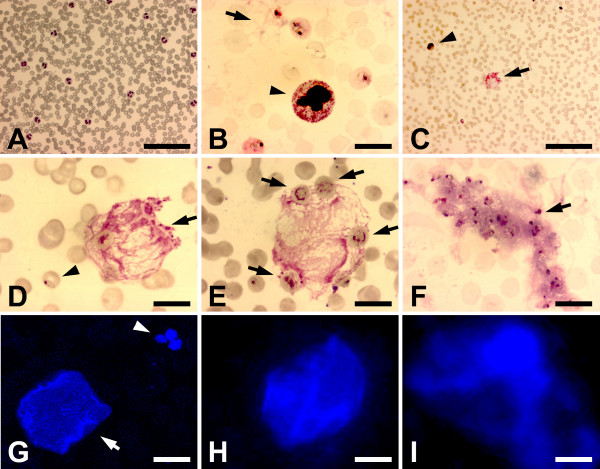
Giemsa- and DAPI-stained peripheral fingerprick blood smears from children 5 years old and younger presenting with uncomplicated malaria. (A) low magnification field of a control smear from a child presenting with fever but no detectable P. falciparum; (B) field showing neutrophil exhibiting toxic granulation and lack of a distinct nuclear membrane (arrowhead)and fibrous material (arrow); (C) field showing NET (arrow) and P. falciparum-infected erythrocyte with a young trophozoite (arrowhead); (D) higher magnification image of field from (C); (E) Fibrous aggregate interpreted to be a NET containing parasitized erythrocytes (arrows); (F) Fibrous aggregate interpreted to be a NET sequestering parasitized erythrocytes; (G) DAPI-stained aggregate resembling fibrous structures in D and E (arrowhead) and normal neutrophil (arrow); (H) DAPI-stained aggregate resembling fibrous structures in D and E; and (I) DAPI-stained aggregate resembling fibrous structure in F. Bars: A, C 100 μm; B, D-F, 10 μm.